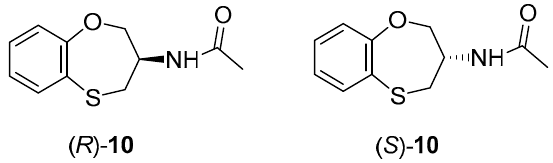
Figure 4. Structures of ( R )- and ( S )- 10